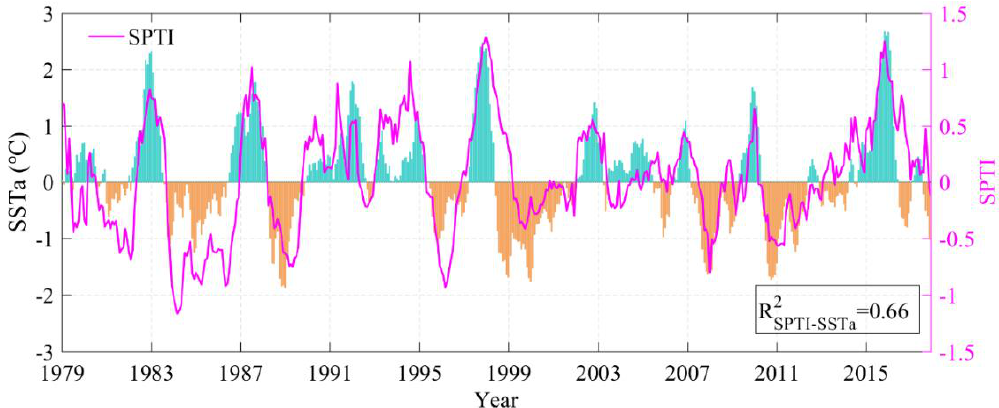
Figure 9. Time series of monthly SPTI in Southeast China with SSTA over the period of 1979 – 2017.